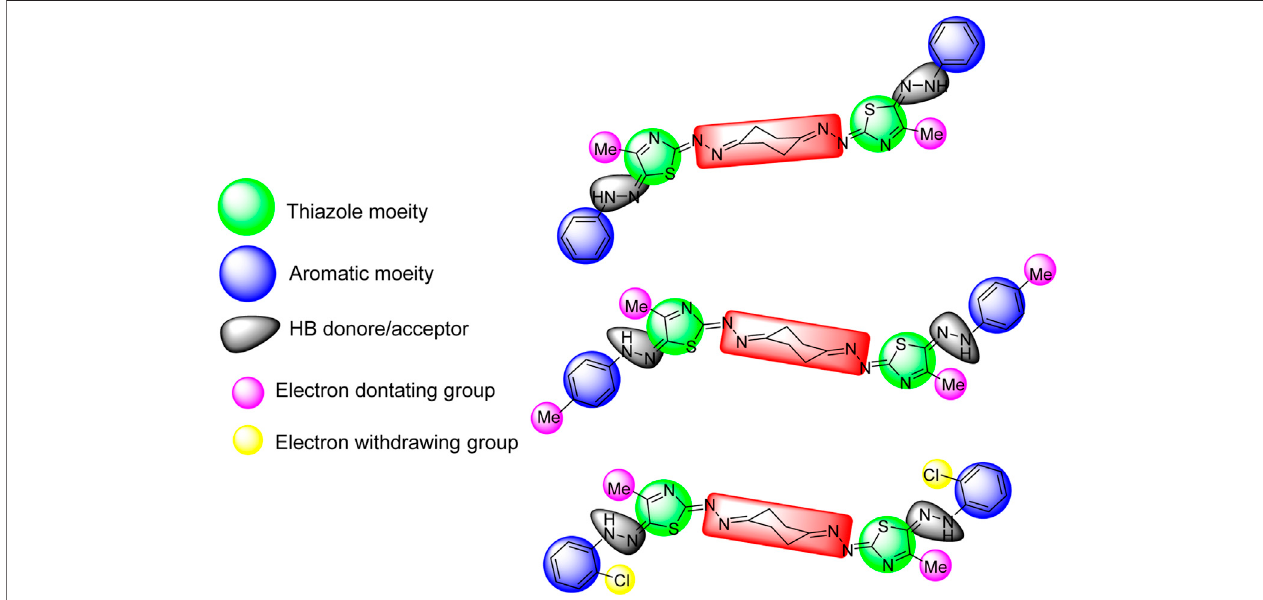
FIGURE 5 | Highlighted pharmacophoric regions for the active compounds 5a, 5b, and 5f, respectively (top to down).